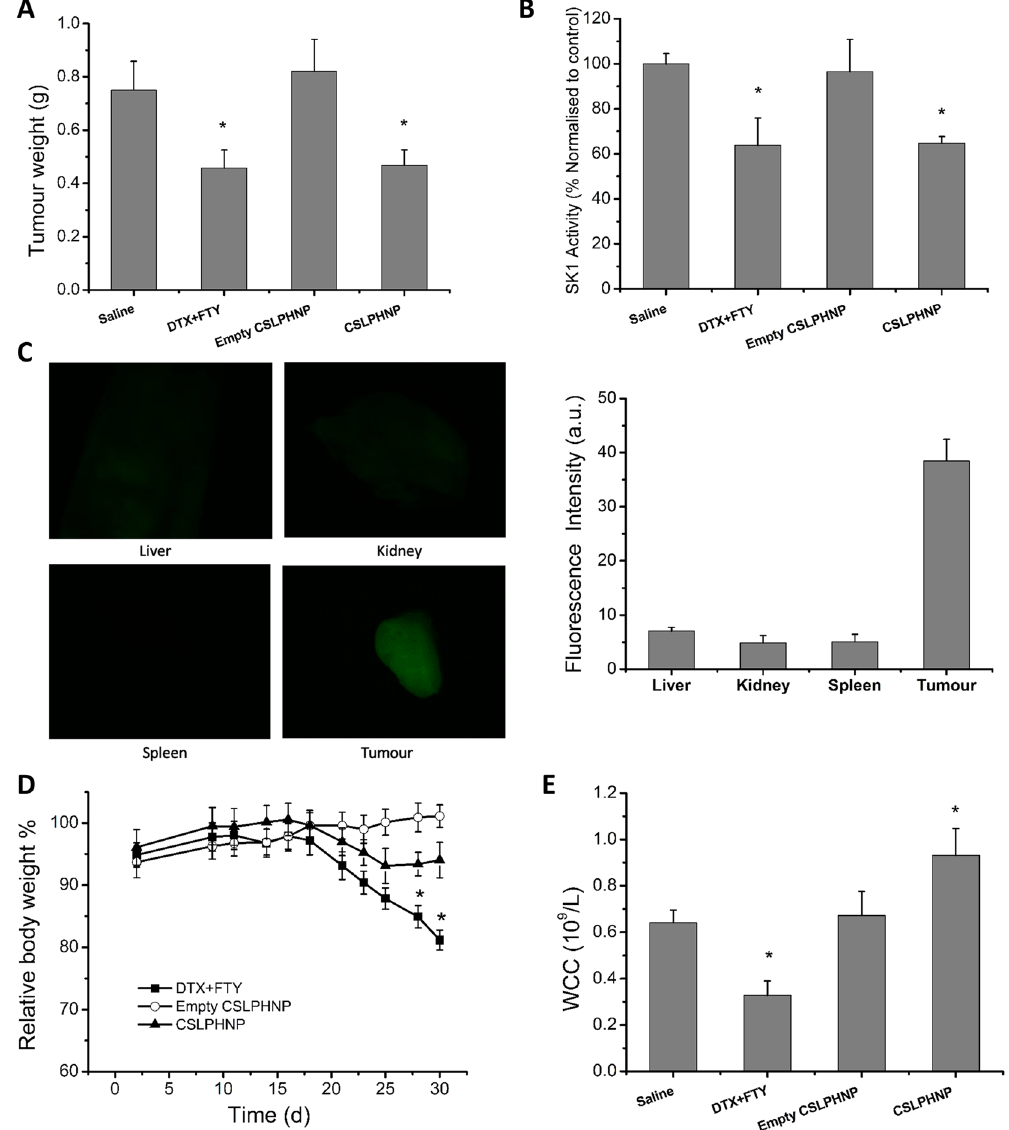
Figure 4. In vivo assessment of CSLPHNPs. NSG immune deficient mice were injected with 1 × 10 6 PC-3 cells and tumors were grown for 3 weeks. Mice were randomized in groups (n = 7) according to treatment as shown in figure, and treated twice a week for two weeks. CF488 fluorophore labelled CSLPHNPs were injected in the last treatment cycle. ( A ) Tumor weight at week five. ( B ) Intratumoral SK1 activity. ( C ) Fluorescent microscopy of mouse organs and primary tumors. Graph (on the right) indicates the levels of fluorescence in each organ quantified using ImageJ. ( D ) Relative body weight. ( E ) White cell count (WCC). Data is presented as mean ± SE, (n = 7), * p < 0.05 versus